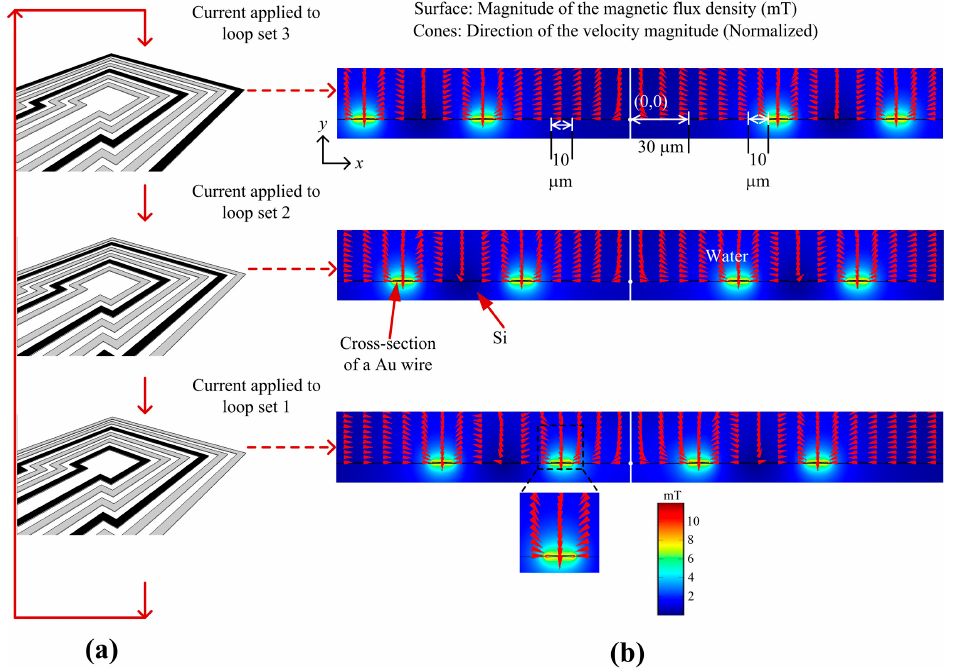
Figure 1. ( a ) Design of the magnetic actuator; ( b ) Magnitude of magnetic flux density (surface plot) when 125 mA of electric current was applied sequentially to the 3 loop